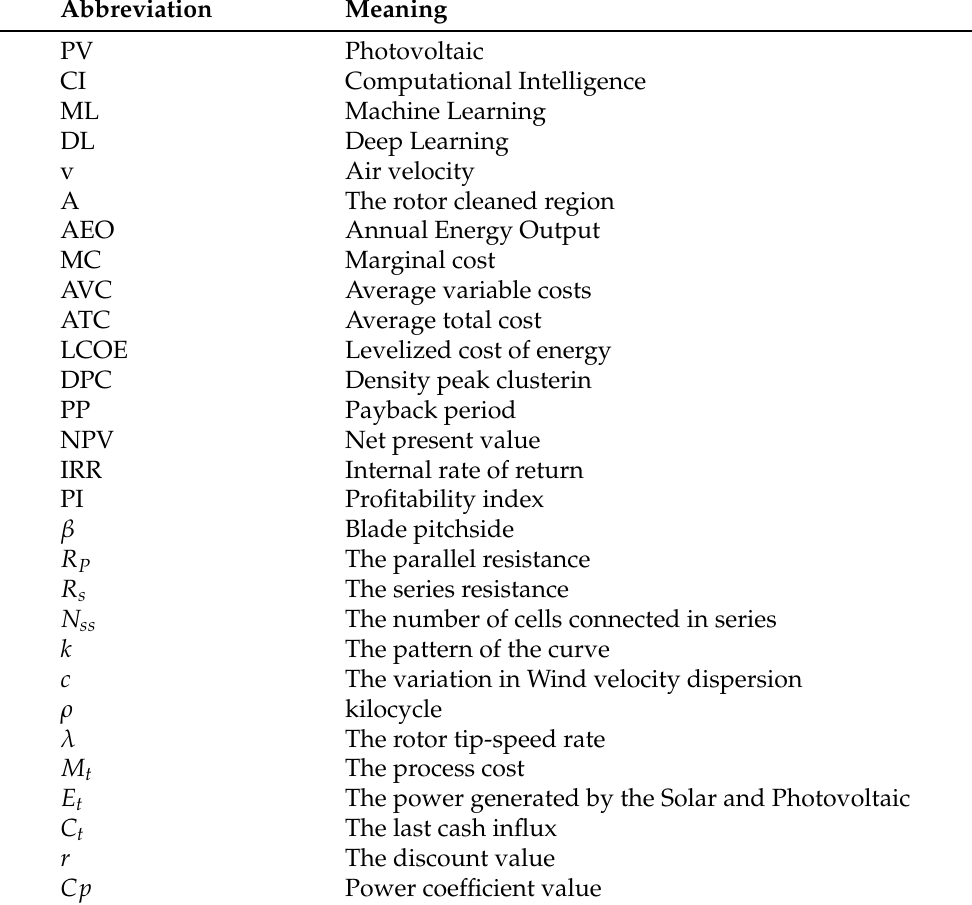
Table 1. List of used